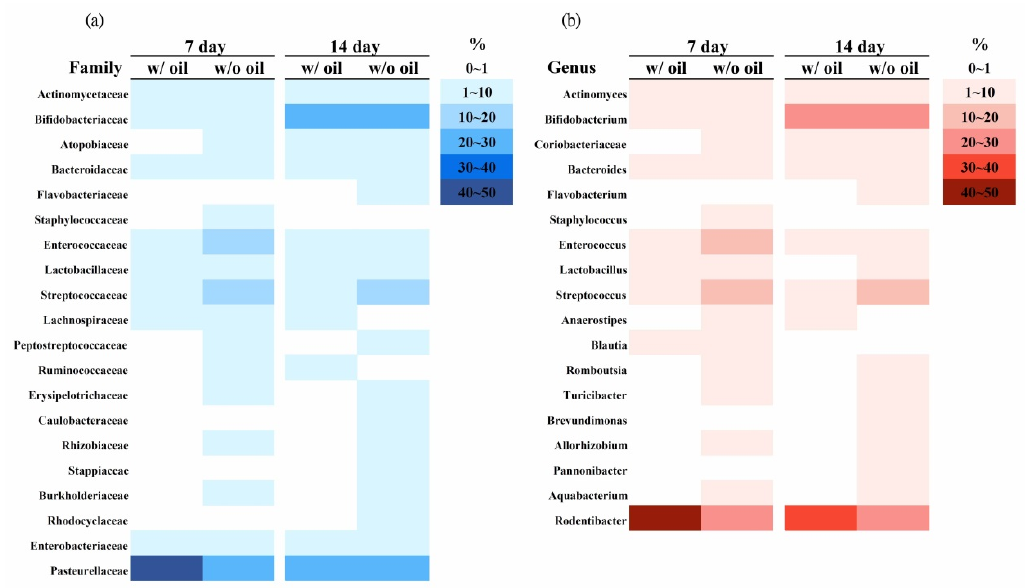
Figure 4. Heatmaps from microbiota analysis of samples treated with or without SM oil at ( a ) family and ( b ) genus levels during the experimental period. Values are presented in percentages.